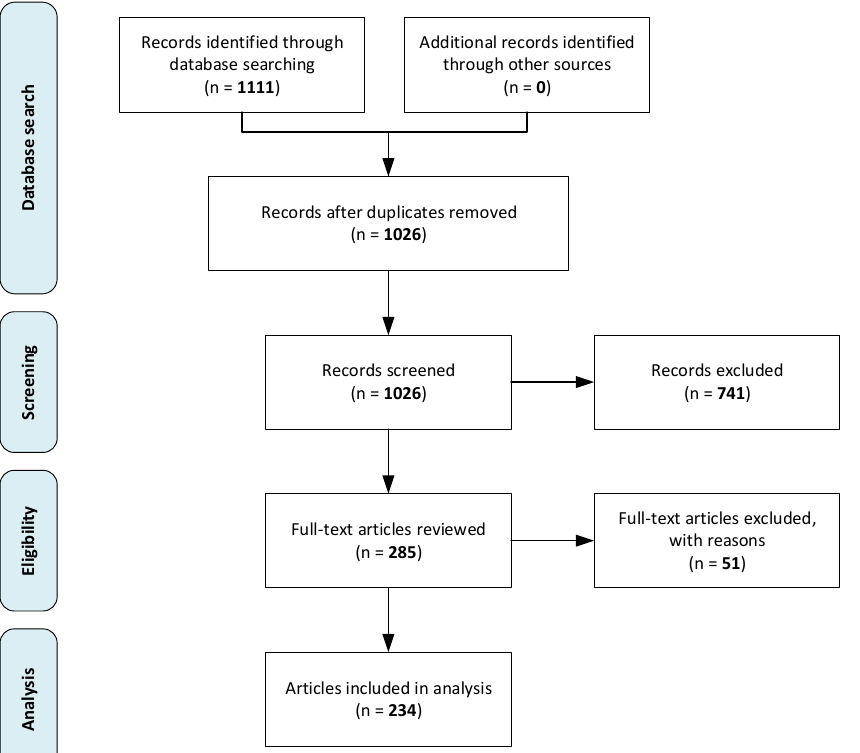
Figure 2. Search process and results, adapted from PRISMA [10].